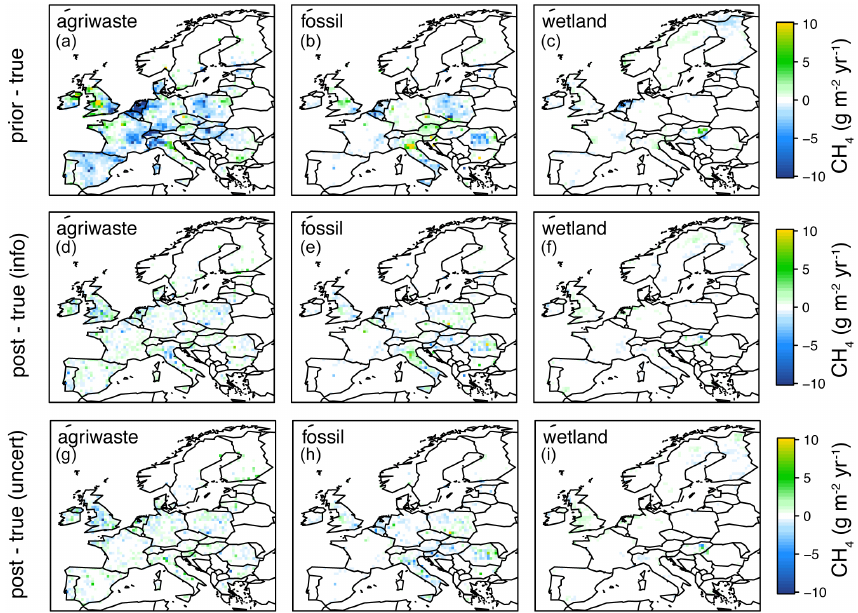
Figure 6. Comparison of the true-prior flux differences (units gm − 2 yr − 1 ) (a–c) versus the true-posterior flux differences for the inversion using sites chosen with the information content criterion (d–f) and the inversion using sites chosen with the posterior uncertainty criterion (g– i) . Note: only the fluxes for the sources agriculture and waste, fossil, and biomass burning sources are shown as the other three sources